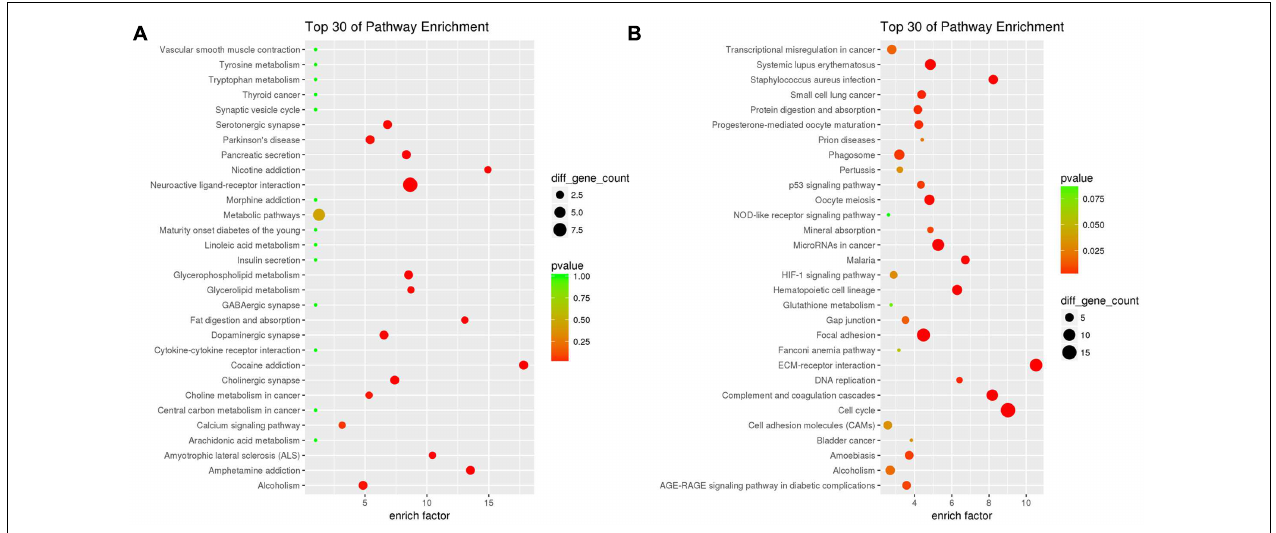
FIGURE 4 | Results of KEGG enrichment analysis for down-DEGs reversed by THSWD (A) and down-DEGs (B) following MCAO.